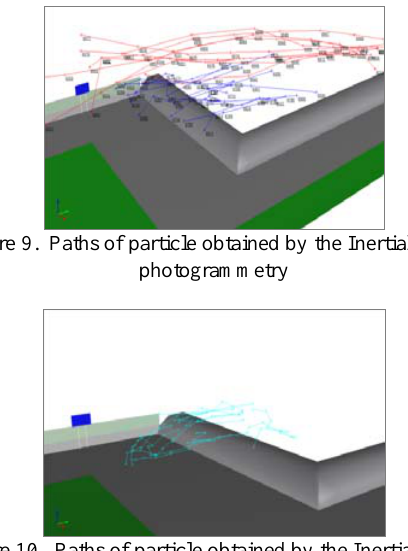
Figure 7. Comparison between trajectories